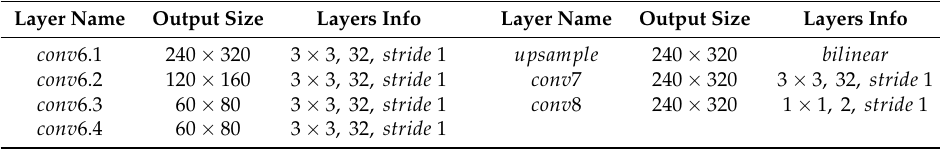
Table 3. The details of the hyper-parameter setting of the